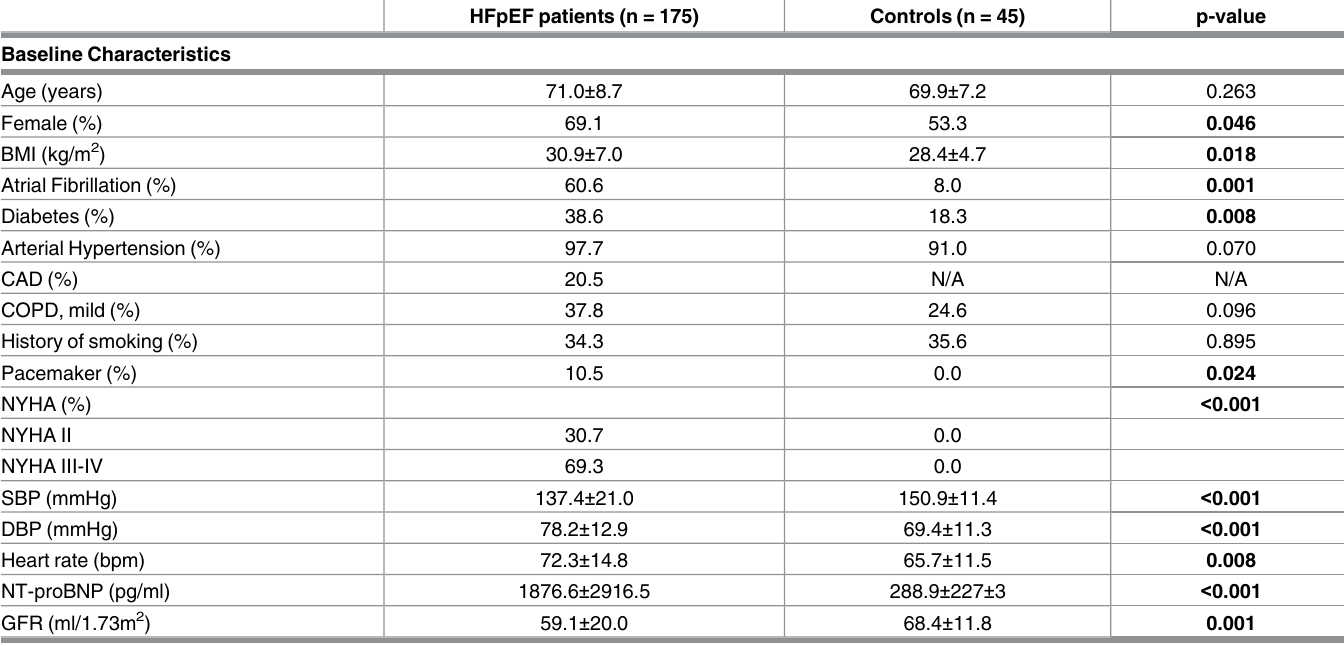
Table 2. Baseline clinical characteristics of HFpEF patients and